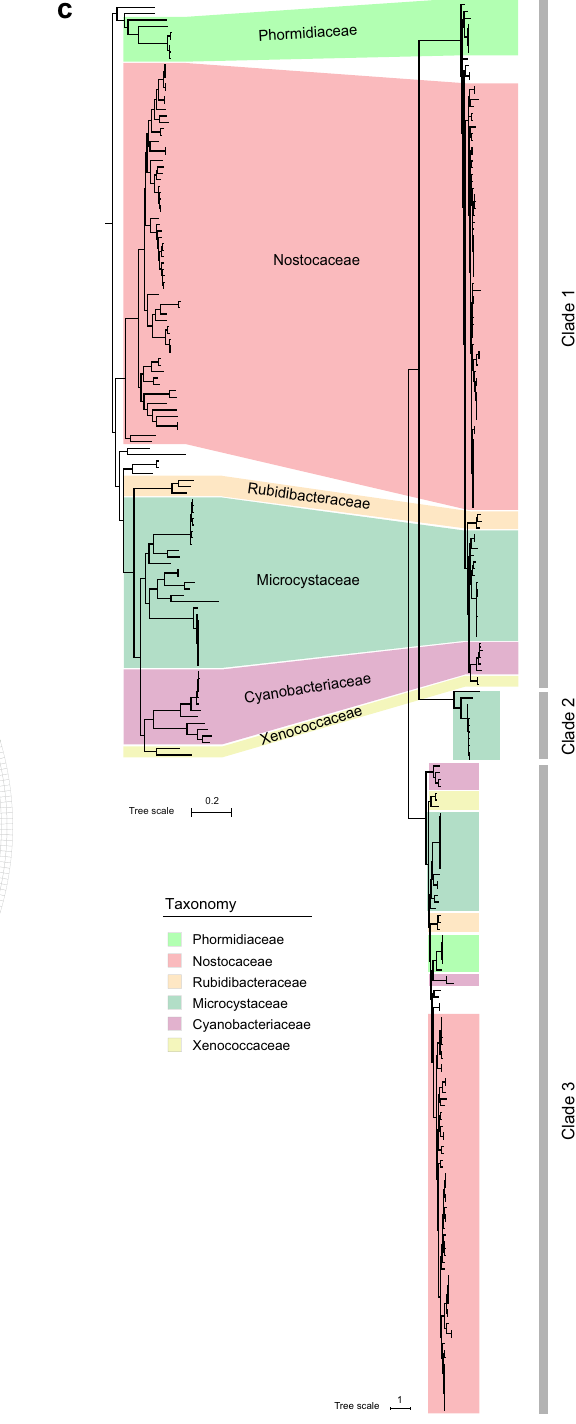
Fig. 2 Putative origin of the dnd system in Cyanobacteria. a Phylogenetic analysis of DndD proteins. The phylogenetic tree is based on the alignments of DndD using MAFFT, fi ltered with trimAl and constructed by the IQ-Tree method, with the LG + C60 + F + G model and 1,000 bootstrap replicates. The tree branches were classi fi ed into different phyla or classes (for Proteobacteria). The green branch belongs to Cyanobacteria, indicating an independent evolutionary path. b Phylogenetic distribution of dnd genes in Cyanobacteria. The phylogenetic tree was constructed by GTDB-tk, and the taxa are shown in different colors according to GTDB. Sericytochromatia was set as the root lineage. The circular heatmap shows the abundance of dnd genes in the corresponding Cyanobacteria genomes. c Consistency of the phylogenetic tree of Cyanobacteriales and DndD proteins. The colored linkages refer to the similar phylogenetic positions of the DndD proteins and genomes of those Cyanobacteria. The 3 phylogenetic clades of DndD proteins are indicated by gray bars on the right. Source data are provided as a Source Data fi